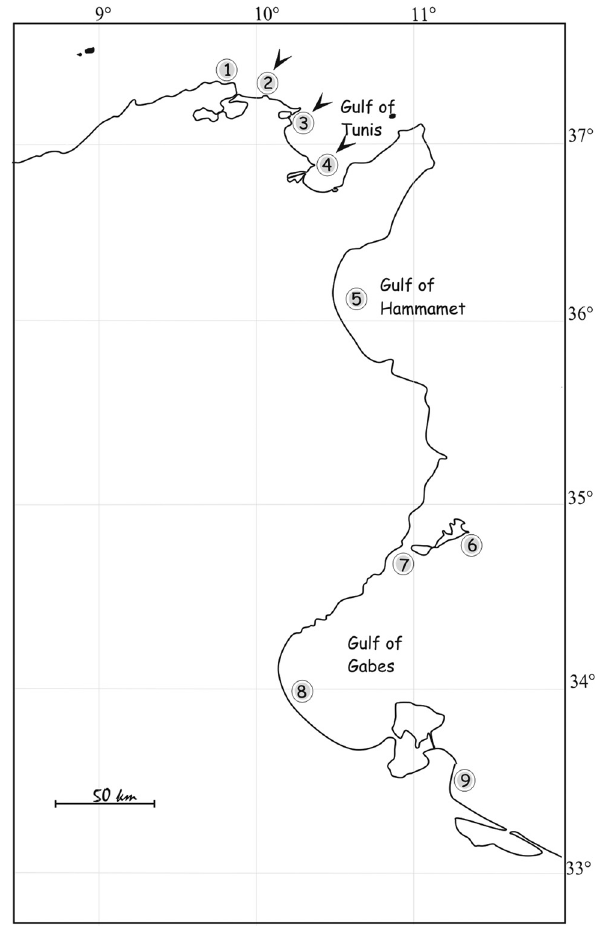
Figure 1. Collection sites (1–9) of Mustelus punctulatus . Arrows indicate where parasitised hosts were